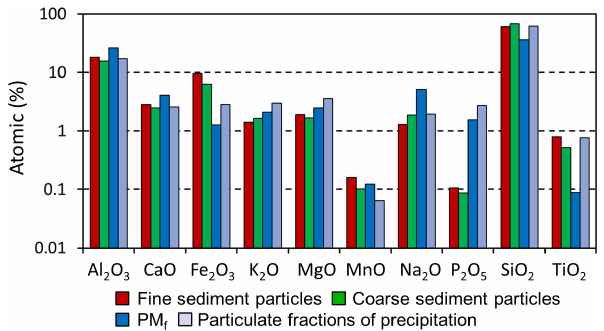
Figure 7. Periodic mean chemical compositions of fine particles and coarse particles in sediments, PM f , and the precipitation filter (the particulate fraction of precipitation) measured by XRF.